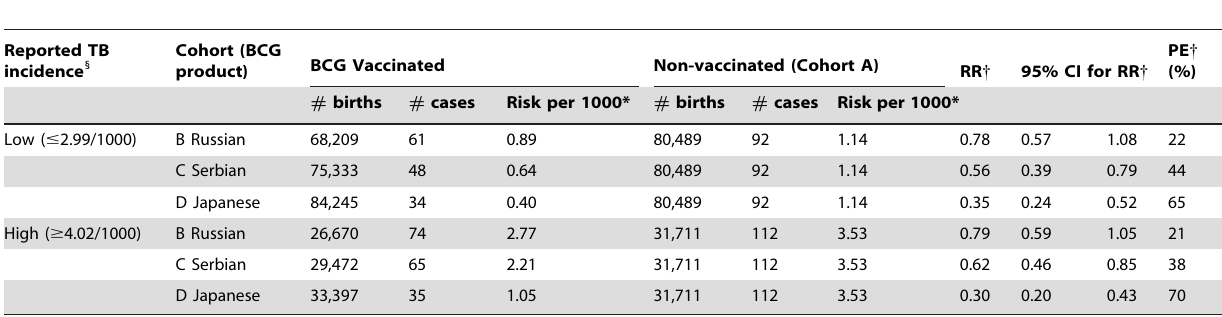
Table 5. Relative risk and TB prevention effectiveness of BCG vaccines in different birth cohorts in areas of low ( # 2.99/1,000) and high ( $ 4.02/1,000) reported TB incidence, Kazakhstan, 2002–2008.